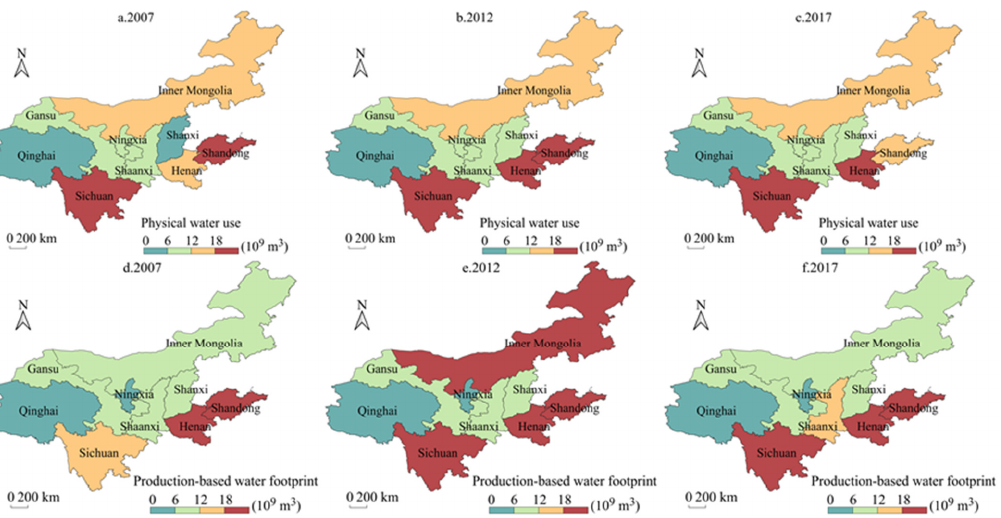
Figure 2. The physical water use and consumption-based water footprint of nine provinces in the Yellow River basin, 2007–2017: ( a – c )-physical water uses in 2007, 2012 and 2017, respectively; ( d – f )- consumption-based water footprints in 2007, 2012 and 2017, respectively. ( d – f )—consumption-based water footprints in 2007, 2012 and 2017,